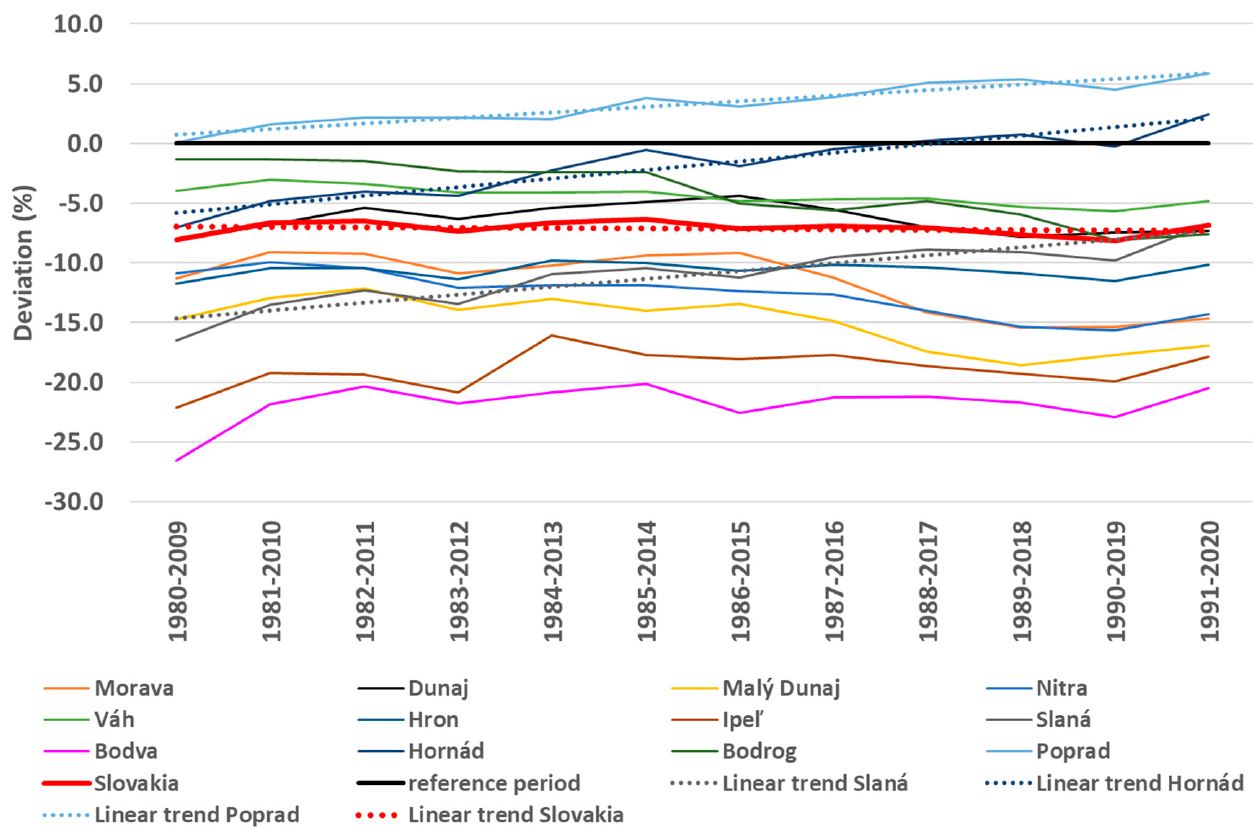
Figure 5. The course of 30-year moving values of the average deviations (%) for the period 1980–2020, reference period 1961–2000.